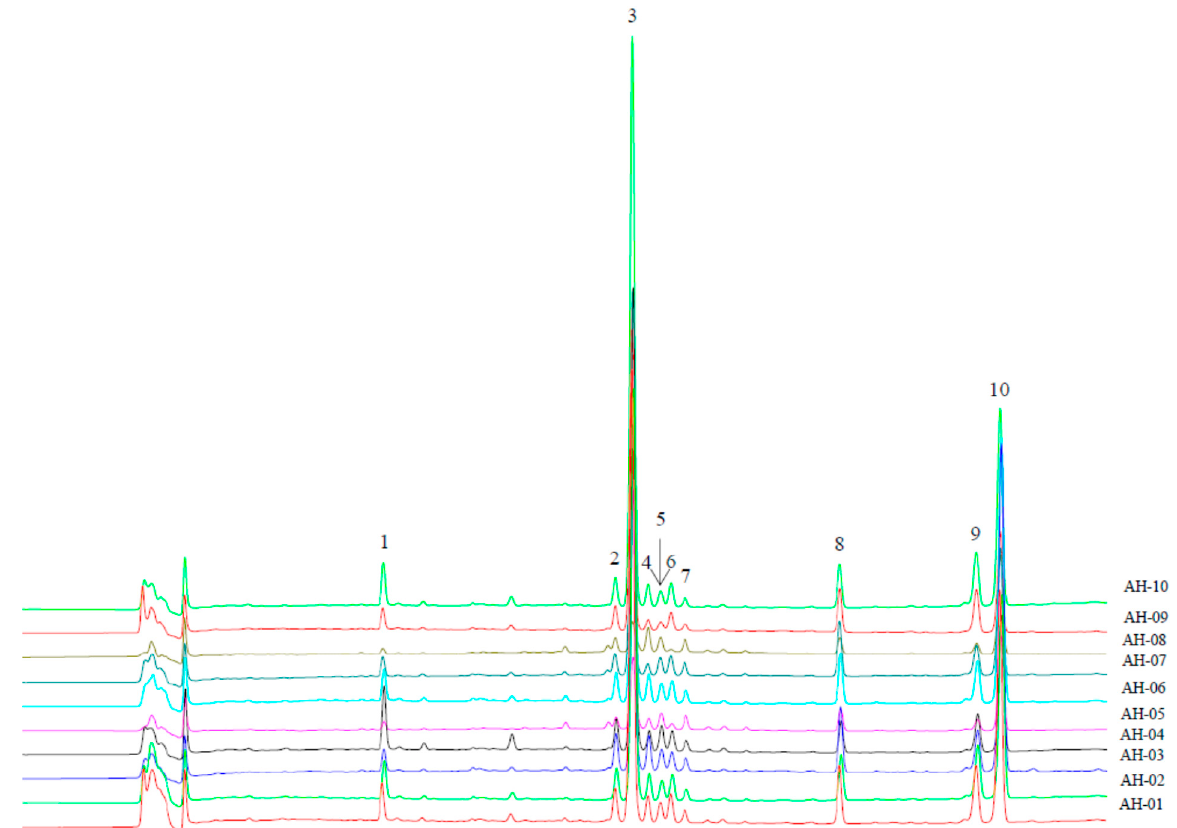
Figure 1. Overlapped chromatograms of AH samples detected at 225